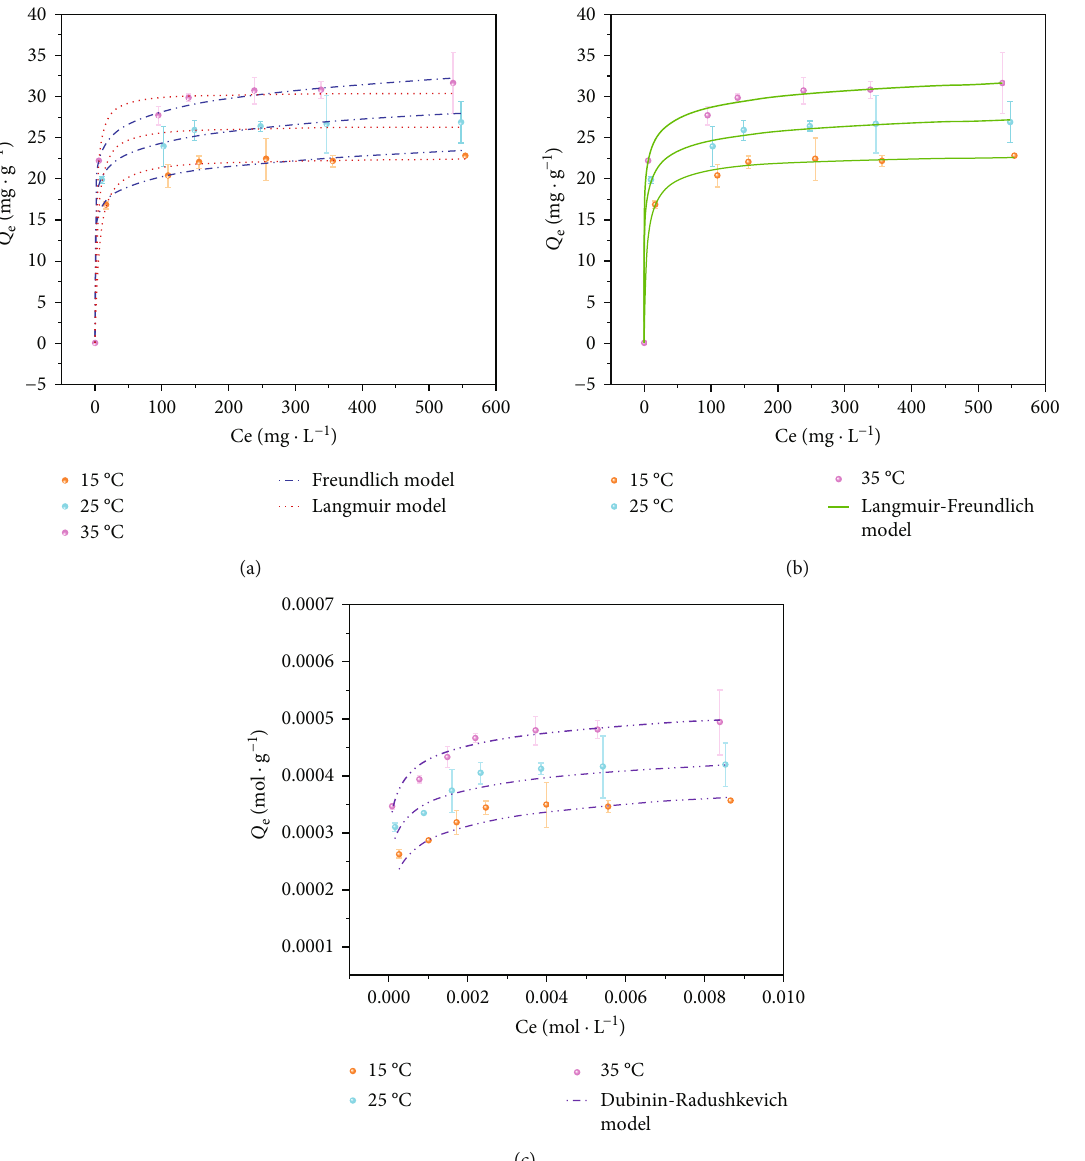
Figure 10: E ff ect of temperature on the adsorption capacity of SP-SBC for Cu(II), and fi tting results of the F and L (a), L-F (b), and D-R (c)